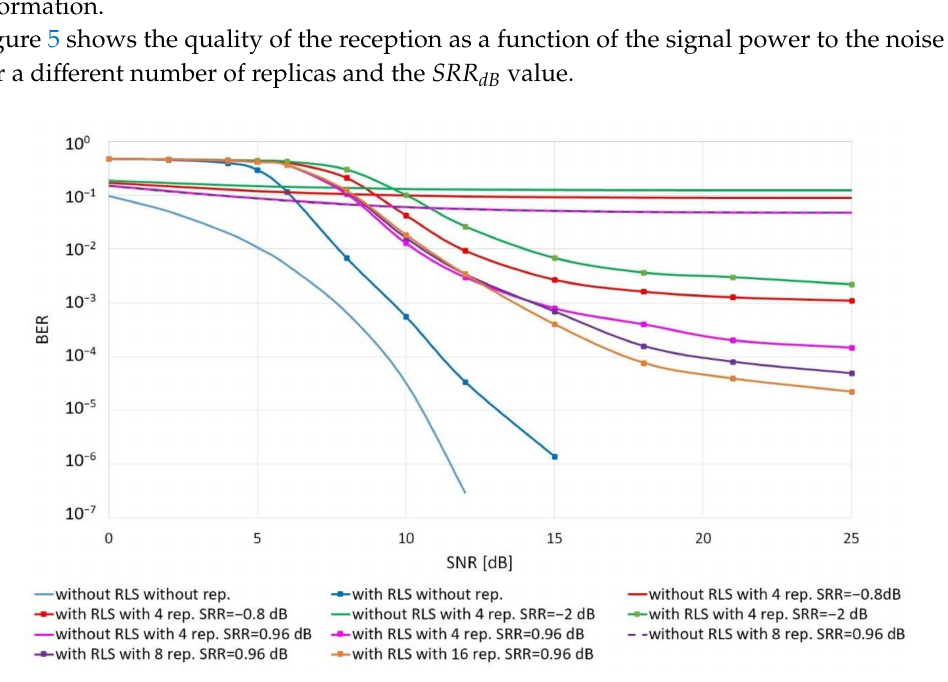
Figure 5. Quality of data transmission in the replica channel as a function of the signal power to the noise power ratio for a single